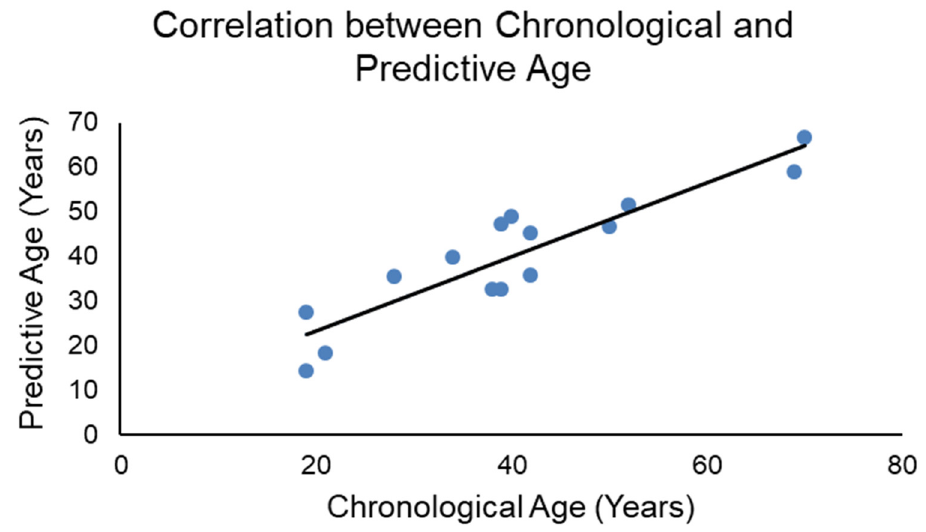
Figure 2. Pearson correlation comparing chronological and predictive age in the training set.